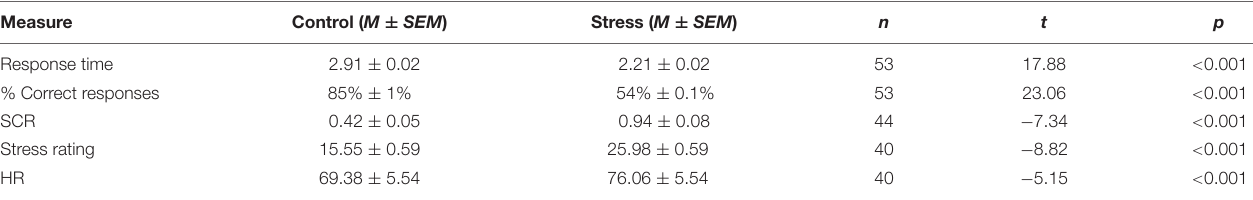
TABLE 2 | Relationship between raw cortisol and other metrics.